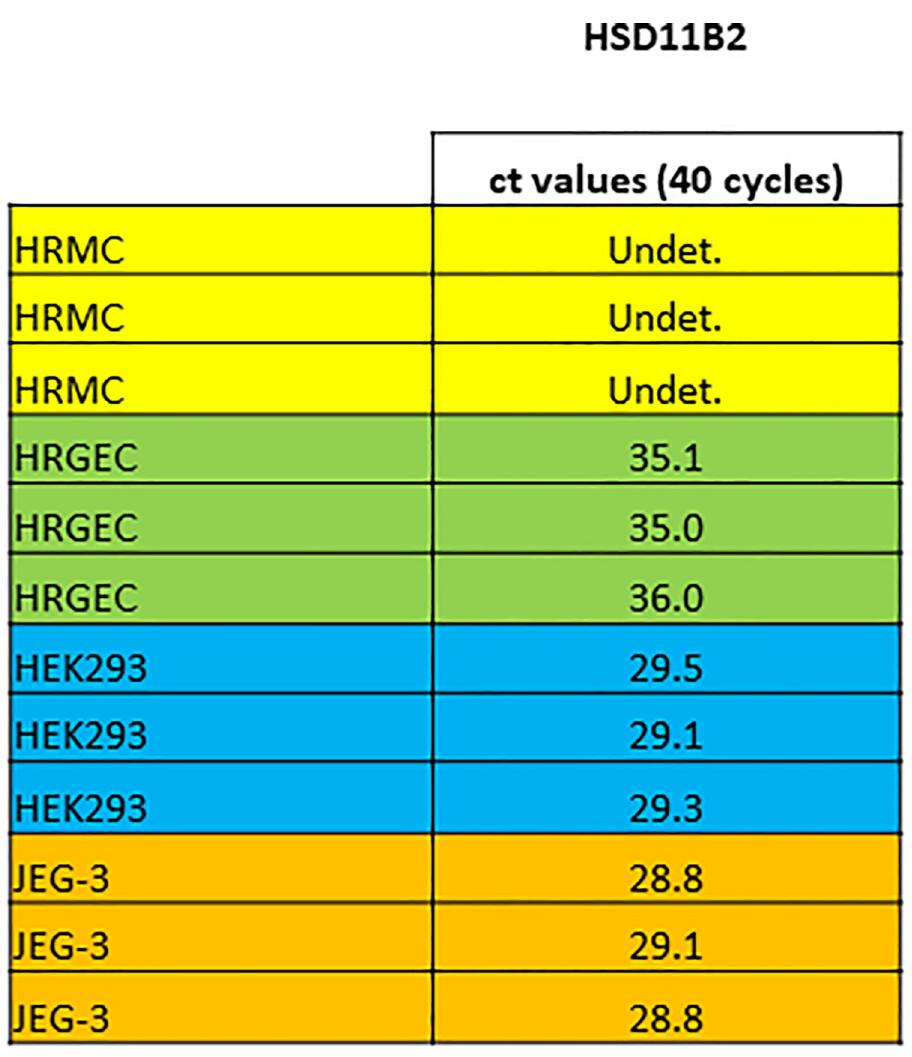
positive at ct values < 35. HRMC: no detection of HSD11B2 (Undet. = undetected), ct > 40. HRGEC: no detection of HSD11B2, ct > 35. HEK293: HSD11B2 detected, ct values ~ 29. JEG-3: HSD11B2 detected, ct values ~ 29. HEK293 and JEG-3 were used as positive controls. � p < 0.05, �� p < 0.01, ��� p < 0.0001, ns = not